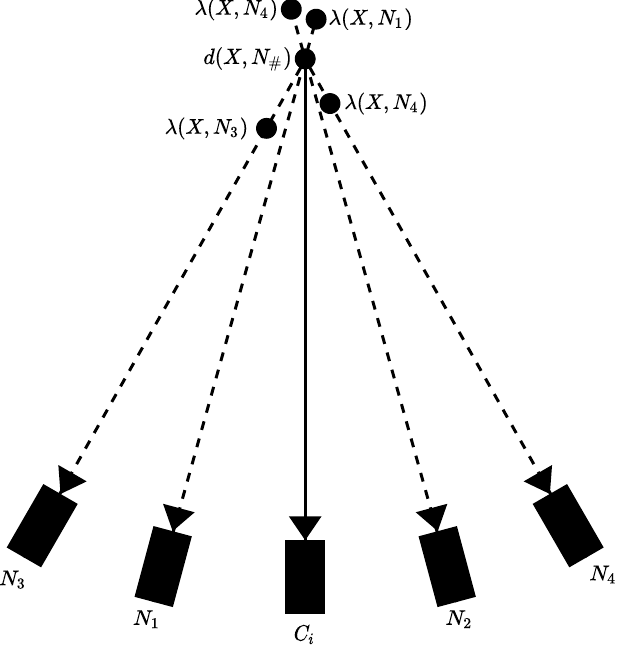
Figure 13. Neighboring depth map test to remove redundancy. C i represents the camera of the depth map, and N 1 − 4 represents the neighboring cameras. The value d ( X , N # ) illustrates the depth value of the projected pixel. λ ( X , N 1 − 4 ) represent the depth value of the pixel projected by the neighboring cameras. The depth values of the camera N 1 and N 2 present depth values larger than the depth value of C i , and as such, the projected points from N 1 and N 2 are considered occluded points and removed from the C i depth map. The point projected by N 4 depth value is close to the depth value of N # , so to avoid redundancy, the point from N 4 is removed as the projection of it can be classified as the point projected by C i . Finally, the point N 3 presents a lower depth value than N # , so its depth map is retained as it does not satisfy either of the conditions stated above. Adapted from [52].